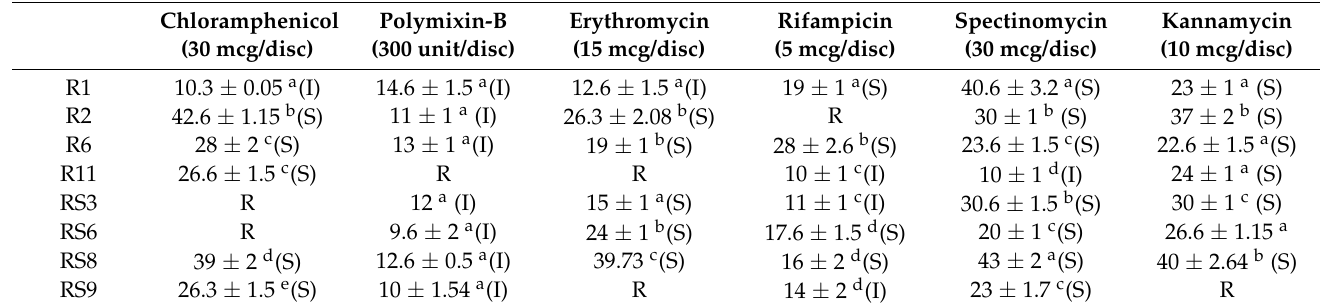
Table 4. Antibiotic sensitivity pattern of endophytic bacterial strains (I = intermediate; S = sensitive; R =